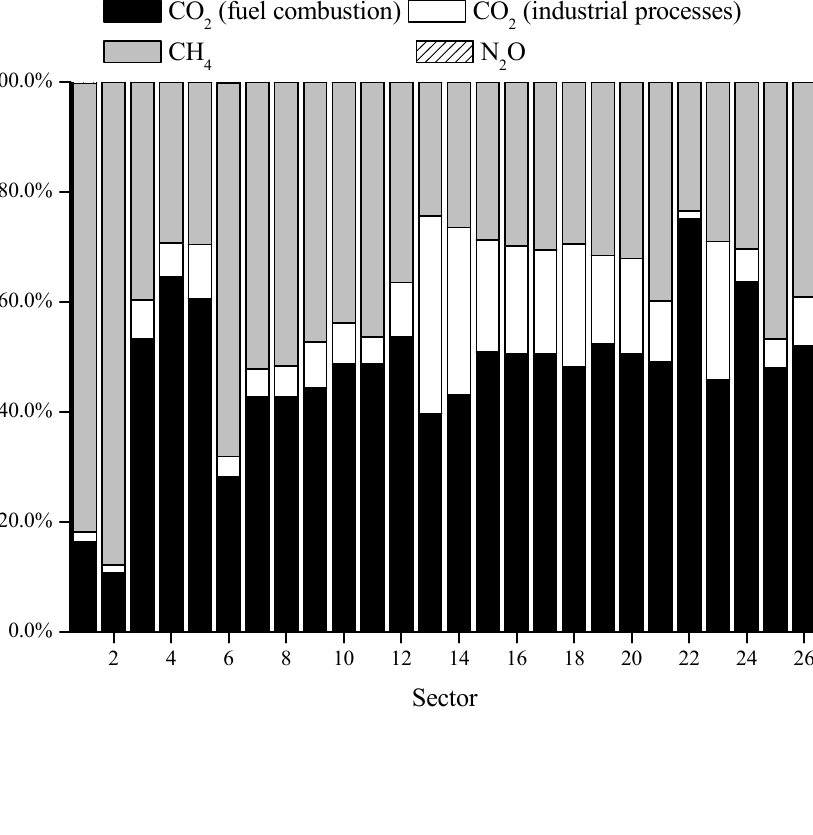
Figure 3. Emission component of the embodied GHG emission intensity by